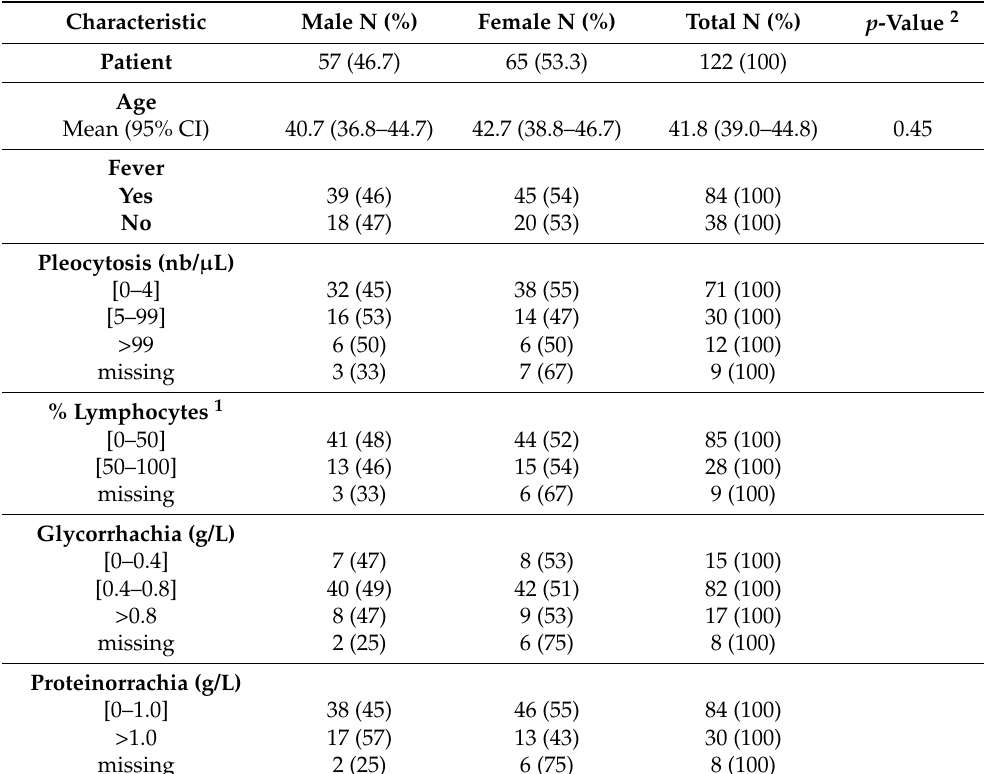
Table 1. Characteristics of encephalitis patients enrolled in the study according to sex, Dakar, January– December